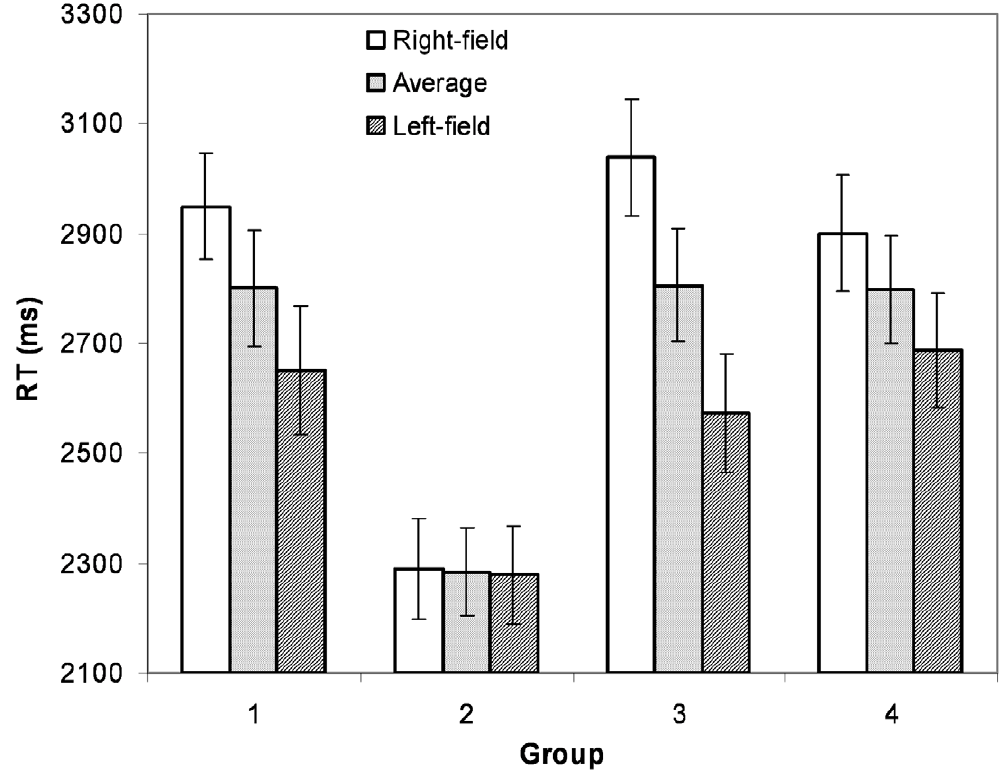
Figure 5. Reaction times in Experiment 2 based on field and group variables. The error bars are standard errors.